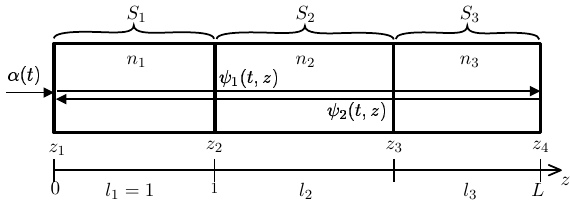
Figure 1. Typical geometric configuration of the domain in a laser with 3